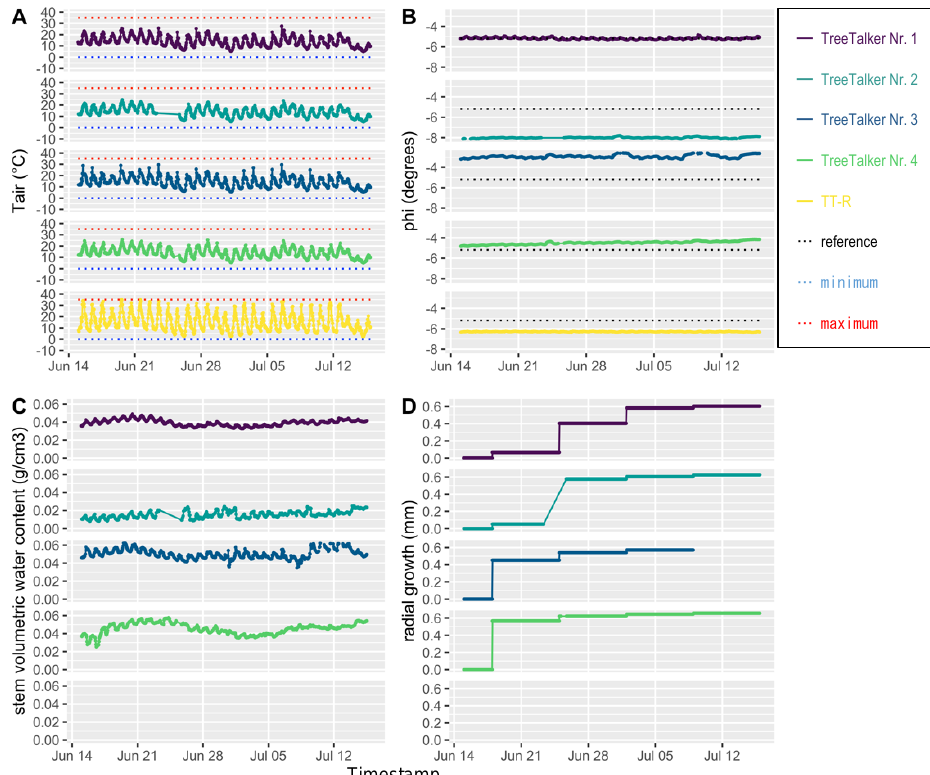
Figure 5. Output of the “ttalkR” plotting utility. ( A ) Air temperature with the reference minimum (dashed blue line) and maximum temperature (dashed red line); ( B ) inclination of the devices; ( C ) stem volumetric content; ( D ) radial growth. The example data refer to four TreeTalkers and a TT-R for the period between 14 June 2021 and 14 July 2021. In ( C , D ), the data from the TT-R are missing because it is a reference device outside of the canopy which is not equipped with the corresponding sensors.